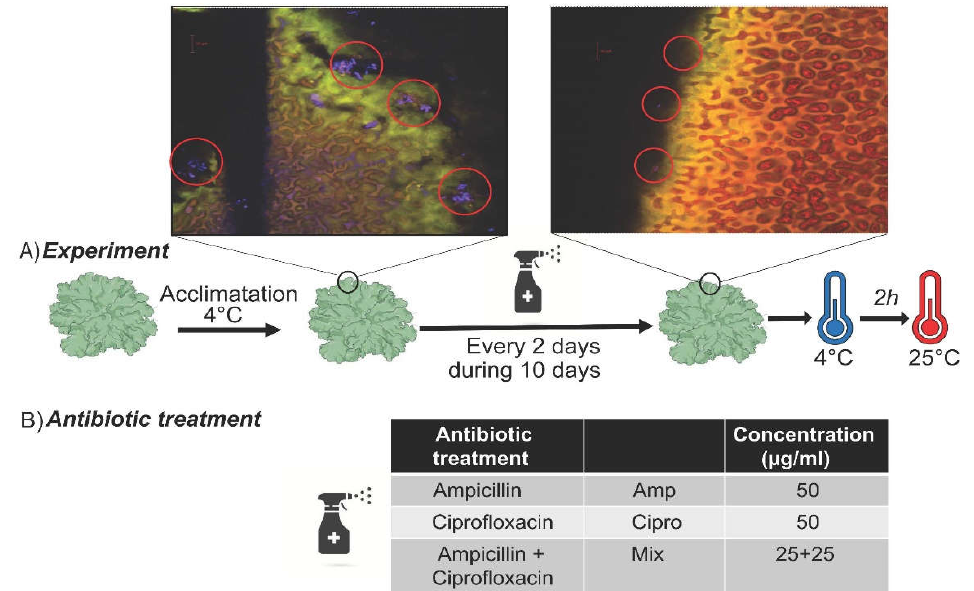
Figure 1. ( A ) Experimental design of antibiotic treatment: Lobaria pulmonaria samples were acclimated to 4 ◦ C for three weeks. After acclimation, samples were treated with different antibiotics + deionized water (treated) or just deionized water (control), treating the lichens on every second or third day for a total of 4 treatments. Thereafter, we took samples exposed to 4 ◦ C. After 2 h of incubation at 25 ◦ C, a second set of samples was taken. Red circles in the figure show areas with bacteria. ( B ) Types of antibiotics used in the experiment, their abbreviations and concentrations.